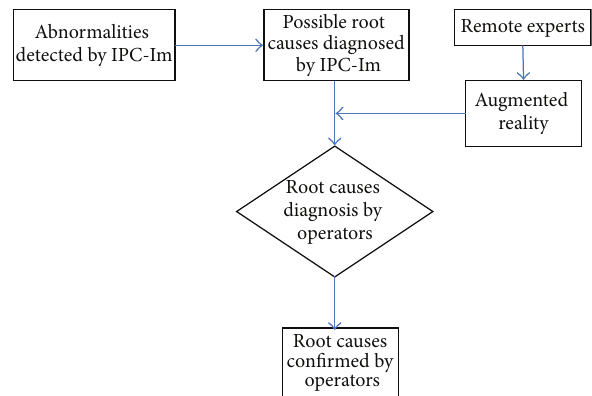
Figure 6: Detection tool with AR application (adapted from